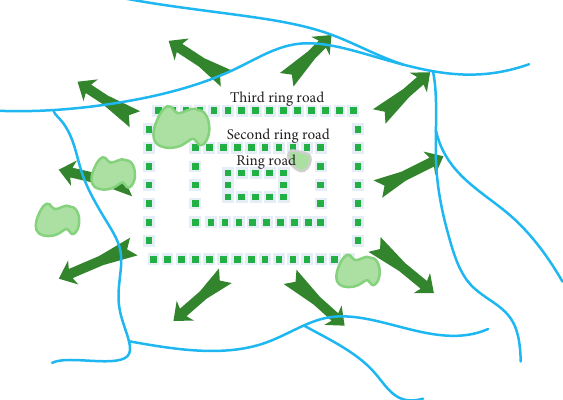
Figure 6: The general structure of the blue-green system plan for the main urban area of Xi’an.